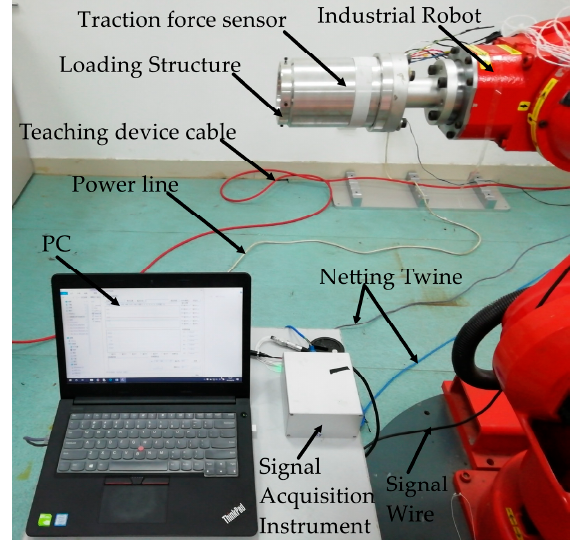
Figure 20. Industrial robot used in calibration